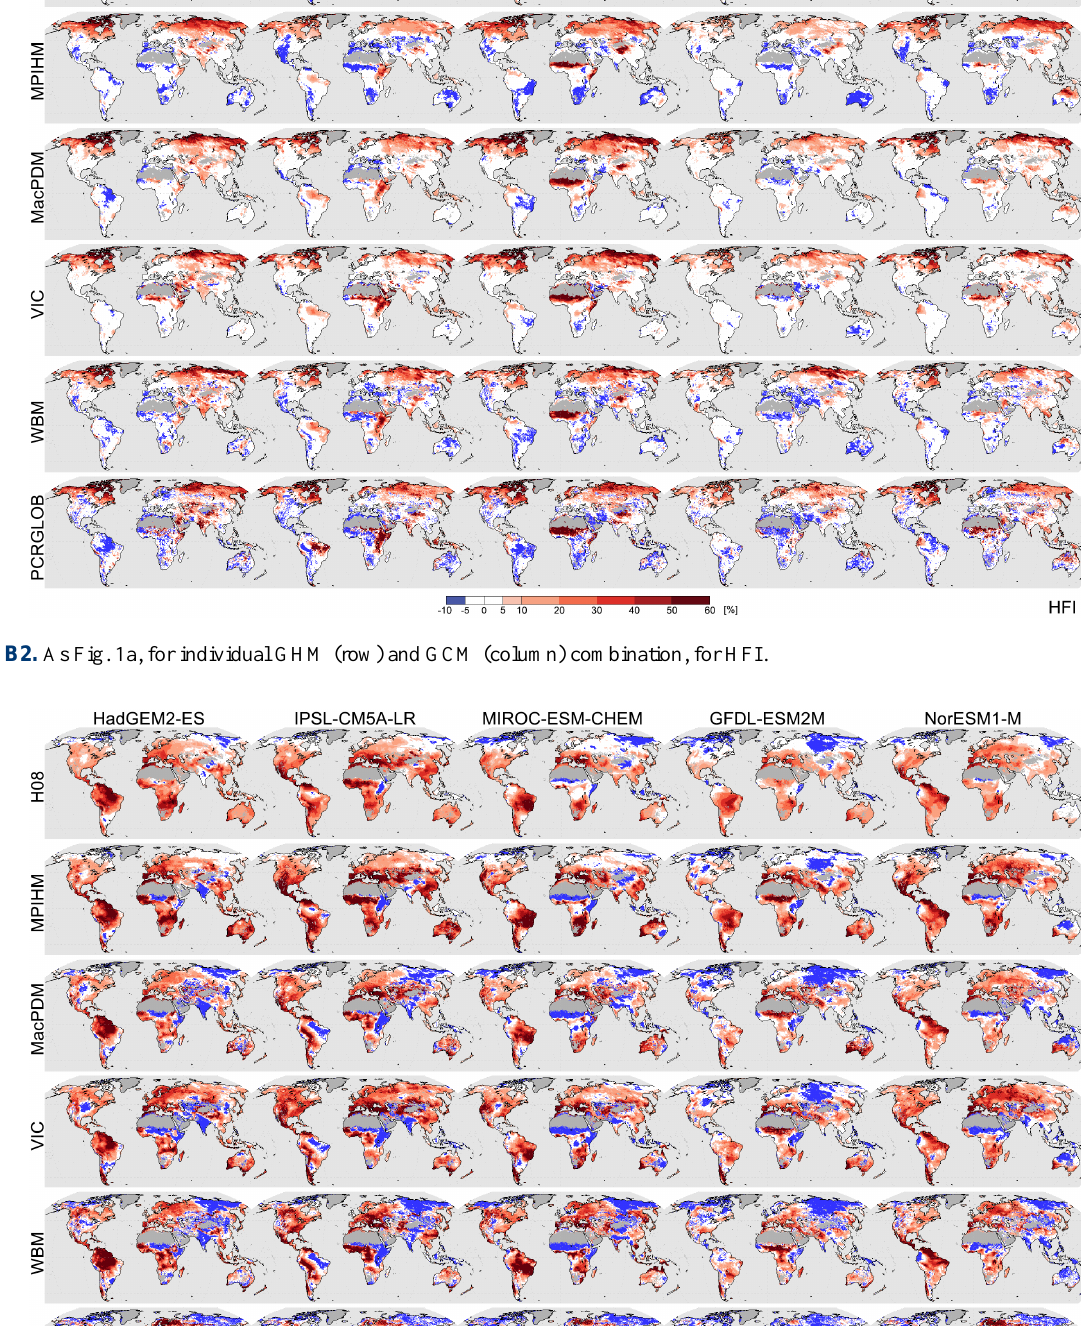
Earth Syst. Dynam., 6, 267–285, 2015